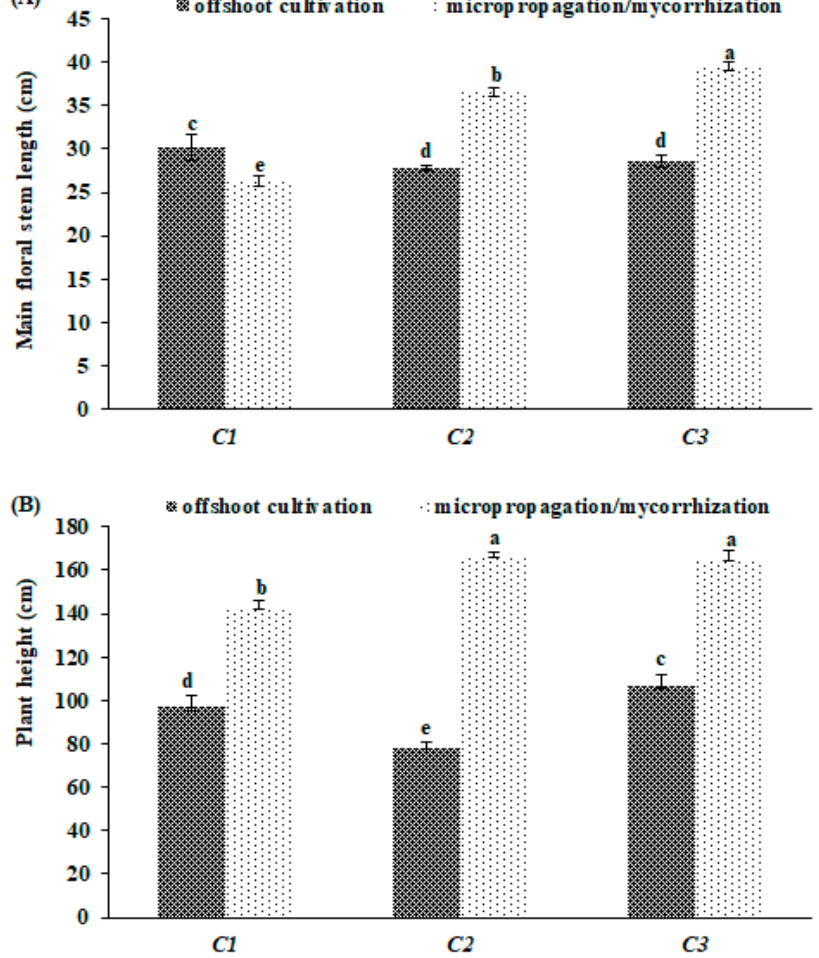
Figure 3. Main floral stem length ( A ) and plant height ( B ) in clone of globe artichoke plants as affected by ‘genotype × propagation method’. Different letters indicate significance at Fisher’s protected LSD (least significant difference) test ( p ≤ 0.05). Vertical bars indicate ± standard deviation.